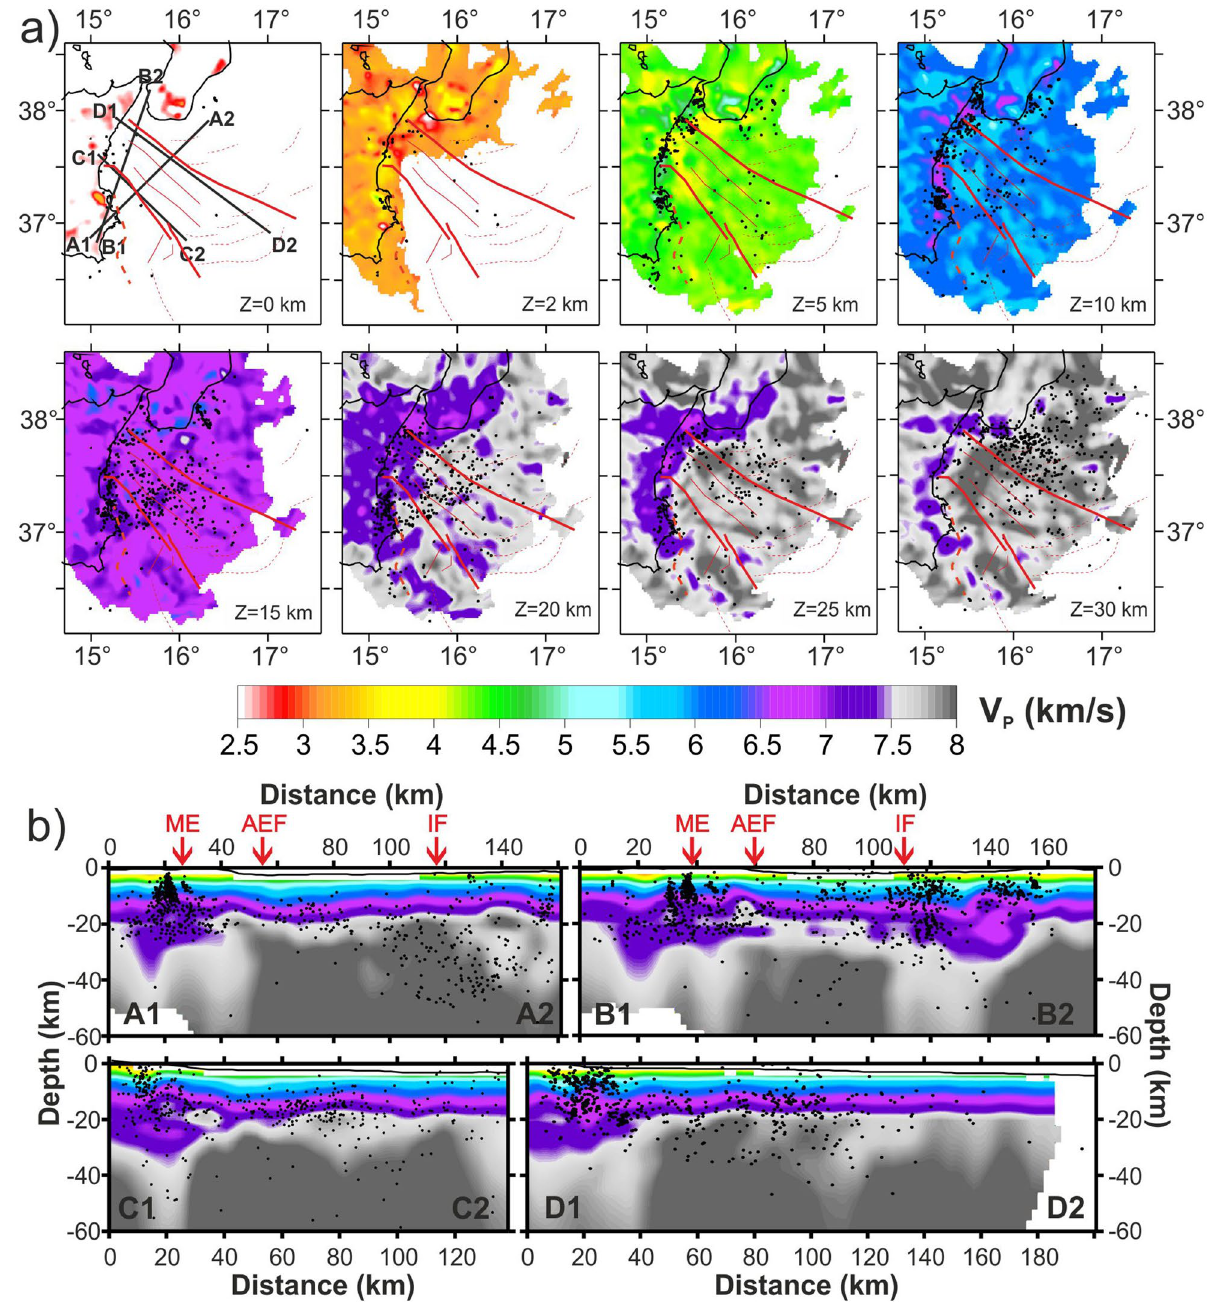
Figure 6. ( a ) Tomography layers of V P velocity model obtained by real data inversion, using, as starting model, the new 1D velocity model computed for the Ionian Sea. The area that is not sampled is white. Black lines in the 0 km layer are for profile tracks. Black dots are earthquakes relocated using the tomoDDPS and the 3D velocity model 32 . ( b ) Profiles of V P velocity model. Profile swath width is within ± 10 km from the profile track. Red arrows on profiles A1-A2 and B1-B2 indicate the position of Malta escarpment (ME), Alfeo-Etna fault (AEF) and Ionian fault (IF). Maps and sections were created using the software Surfer (Version 8.09.2391; http://www. golde nsoft ware.com/produ cts/surfe r) and edited using Corel Draw 2018 (Version 20.0.0.633; http://www.corel